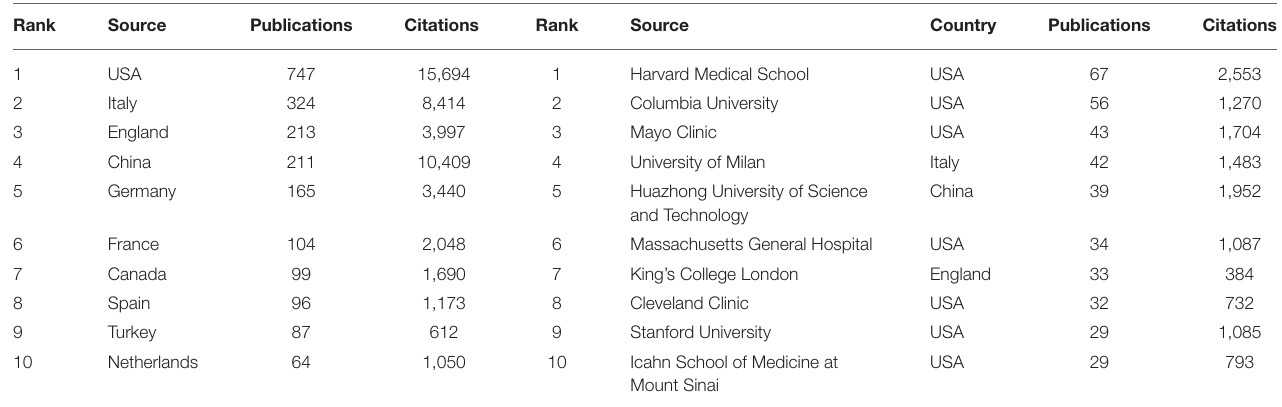
TABLE 2 | Detailed information of the top ten countries and